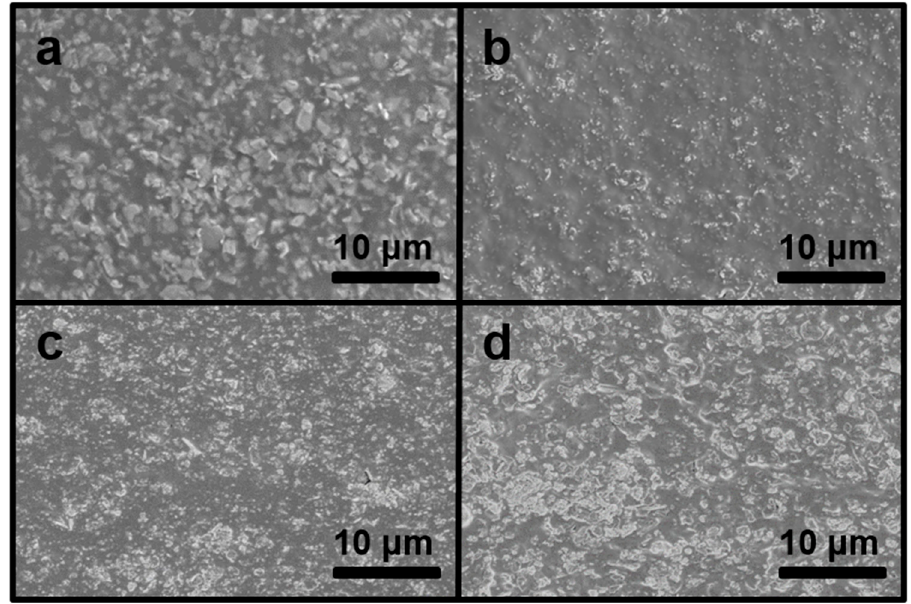
Figure 4. SEM observation of HPMC/MoS 2 /Al 2 O 3 composites: ( a ) HPMC/MoS 2 , ( b ) Al 2 O 3 1 wt.%, ( c ) Al 2 O 3 2 wt.%, and ( d ) Al 2 O 3 3 wt.%.